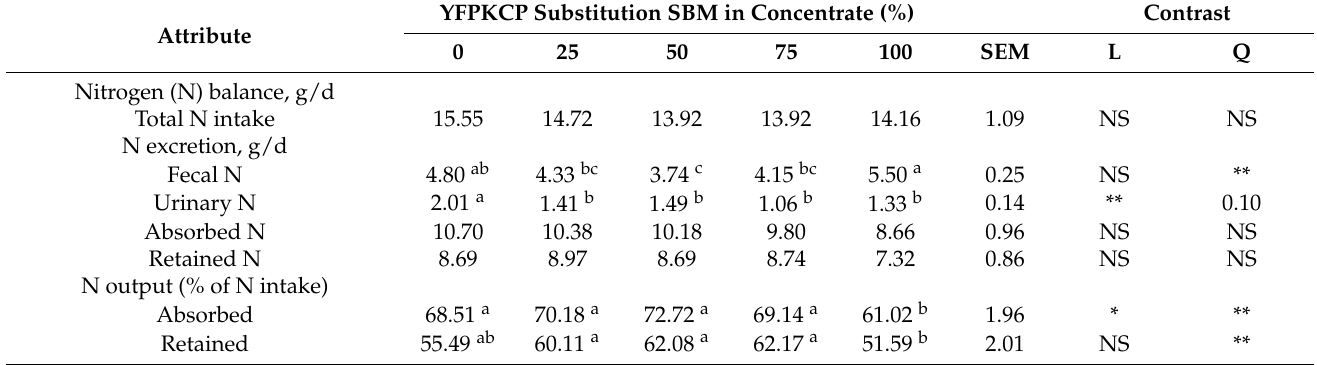
Table 8. Nitrogen consumption in goats given different levels of fermented palm kernel cake as a substitute for soybean